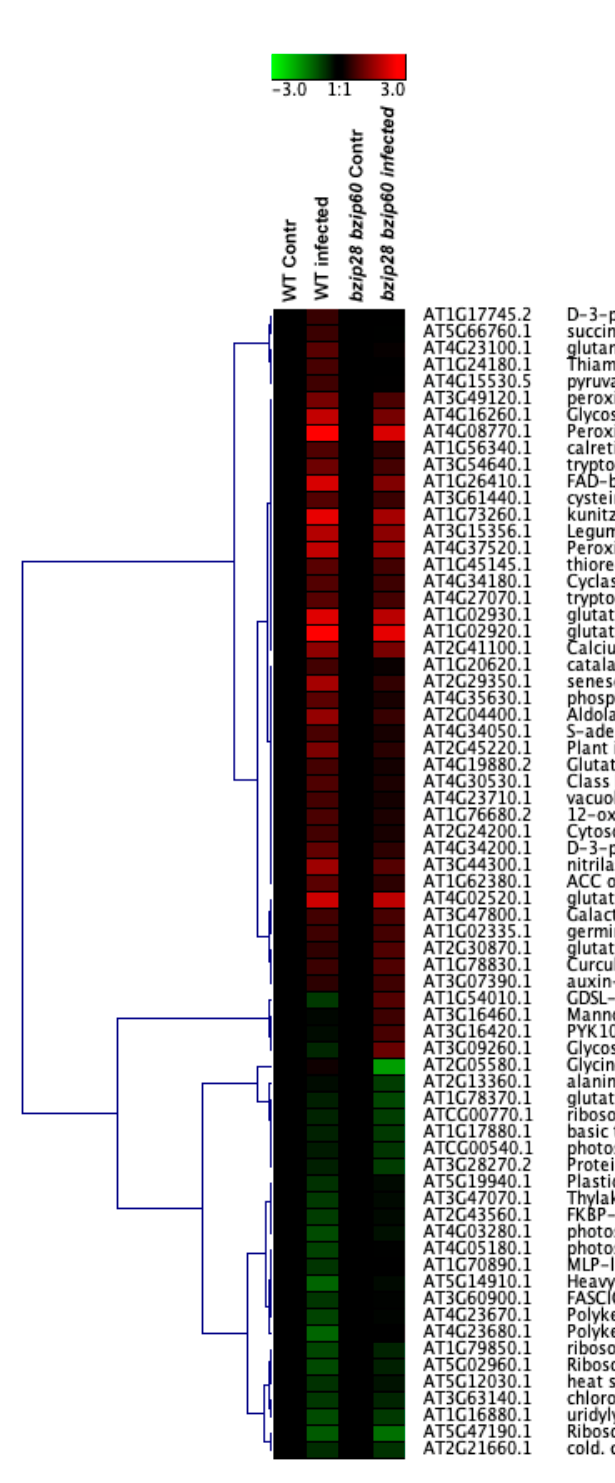
Figure 7. Differentially represented proteins in leaves from WT and bzip28 bzip60 mutant Arabidopsis plants infected by D. gigantea for 24 h, as deduced by proteomic analysis. An independent pairwise comparison of leaves of infected WT vs. non-infected WT plants, as well as of infected bzip28 bzip60 mutant vs. non-infected bzip28 bzip60 mutant ones is shown. A heat-map representation and hierarchical clustering analysis of differentially represented proteins is given. The latter was performed using Genesis 1.8.1 platform.